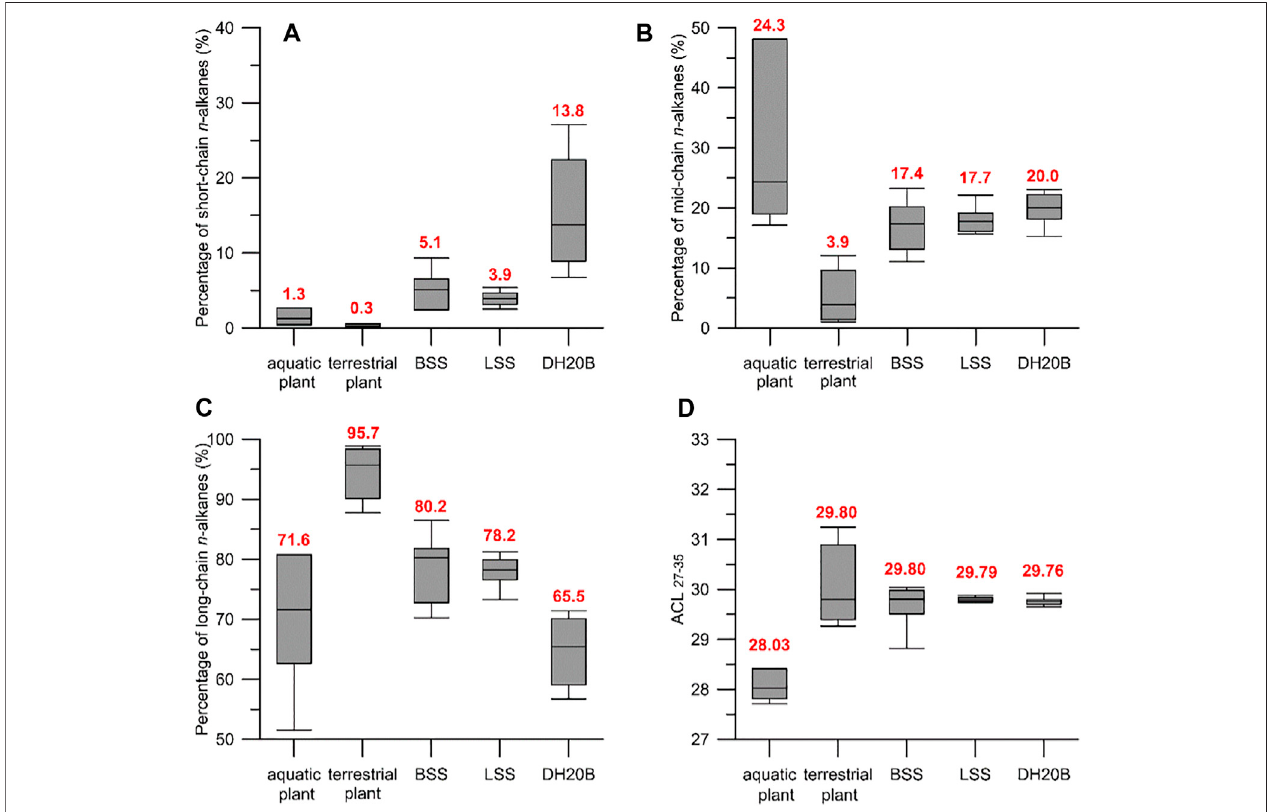
FIGURE4| Percentageofdifferentchainlength n -alkanesandACLresultsfromdifferentsamples. (A) Percentageofshort-chain n -alkanes; (B) percentageofmid- chain n -alkanes; (C) percentage of long-chain n -alkanes; and (D) ACL of n -alkanes with carbon numbers from 27 to 35.